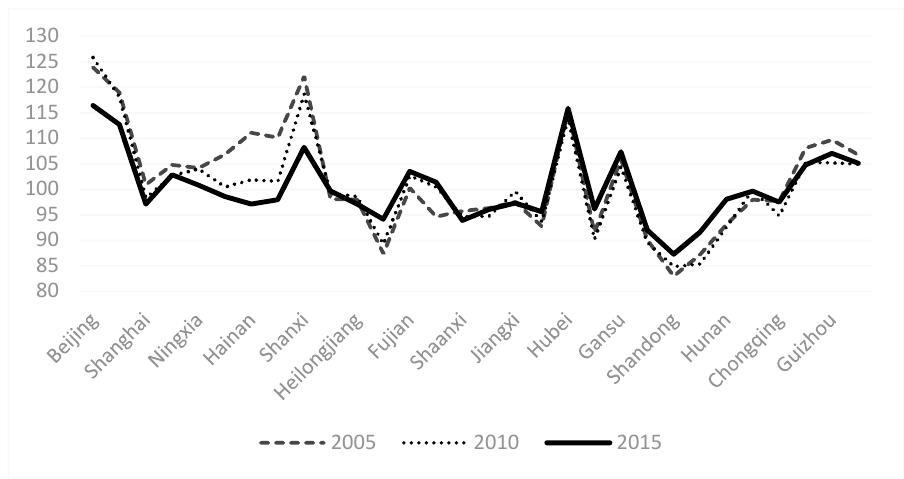
Figure 1. Index of HA level in 30 provinces of China in 2005, 2010 and 2015.